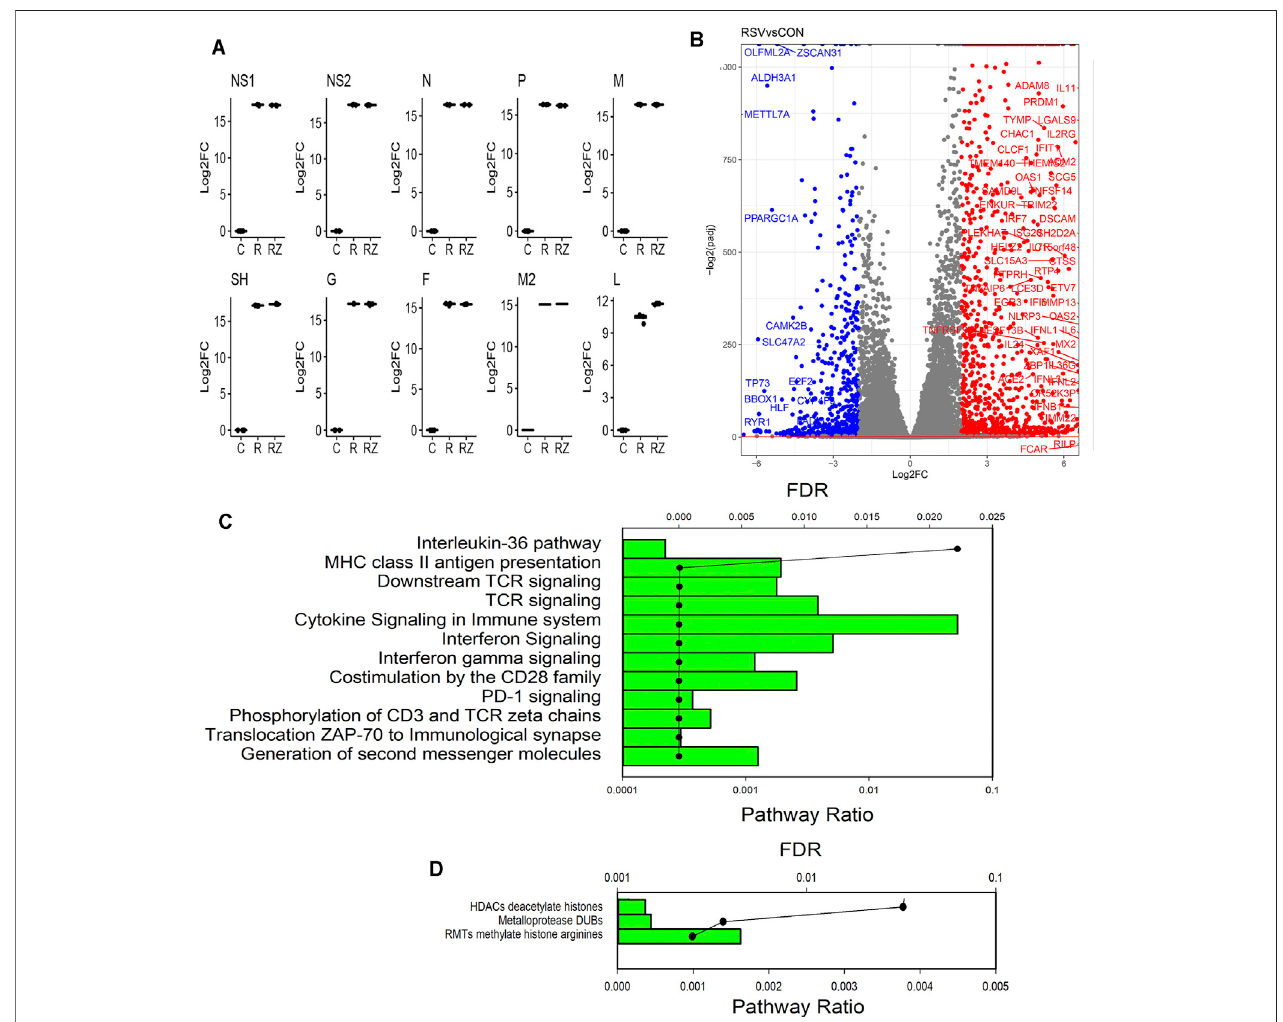
FIGURE 3 | RSV-induced gene regulatory network. (A) Quantitation of RSV transcripts. Log2 fold change (log2FC) values of short-read RNA-Seq are plotted by quartile(25 – 75%)boxplots.Thehorizontallineisthemeanvalue.Foreachtranscriptgroup,comparisonsaresigni fi cantlydifferentfortheRSV-infectedvsmock-infected (CON) contrast. DZD2, RNA-dependent RNA polymerase; F, fusion protein; G, glycoprotein; M, matrix protein; N, nucleoprotein; NS, nonstructural protein; P, phosphoprotein; and SH, small hydrophobic protein. (B) Volcano plot of differentially expressed genes (DEGs) in CON vs RSV-infected cells. X axis, log2fold change of transcripts/million (TPM). A positive value in red indicates that the gene is upregulated by RSV infection. Y axis, − log10(adjusted p value using Benjamini- Hochberg, padj). Blue are genes downregulated by RSV (log2FC > 2). Red are genes upregulated. (C) Genome Ontology (GO) enrichment of RSV-upregulated genes. Genes with 4-fold change in TPM (RSV vs CON) and adjusted p -value < 0.01 were analyzed for pathway enrichment (reactome.org). For each gene set, the fraction of genes represented in the pathway and the signi fi cance (false discovery rate, FDR) are plotted. Shown are the pathways with FDR < 0.05. (D) GO enrichment of RSV-downregulated genes. Genes with < -4-fold change in TPM (RSV vs CON) and adjusted p -value of < 0.01 were analyzed for pathway enrichment as given